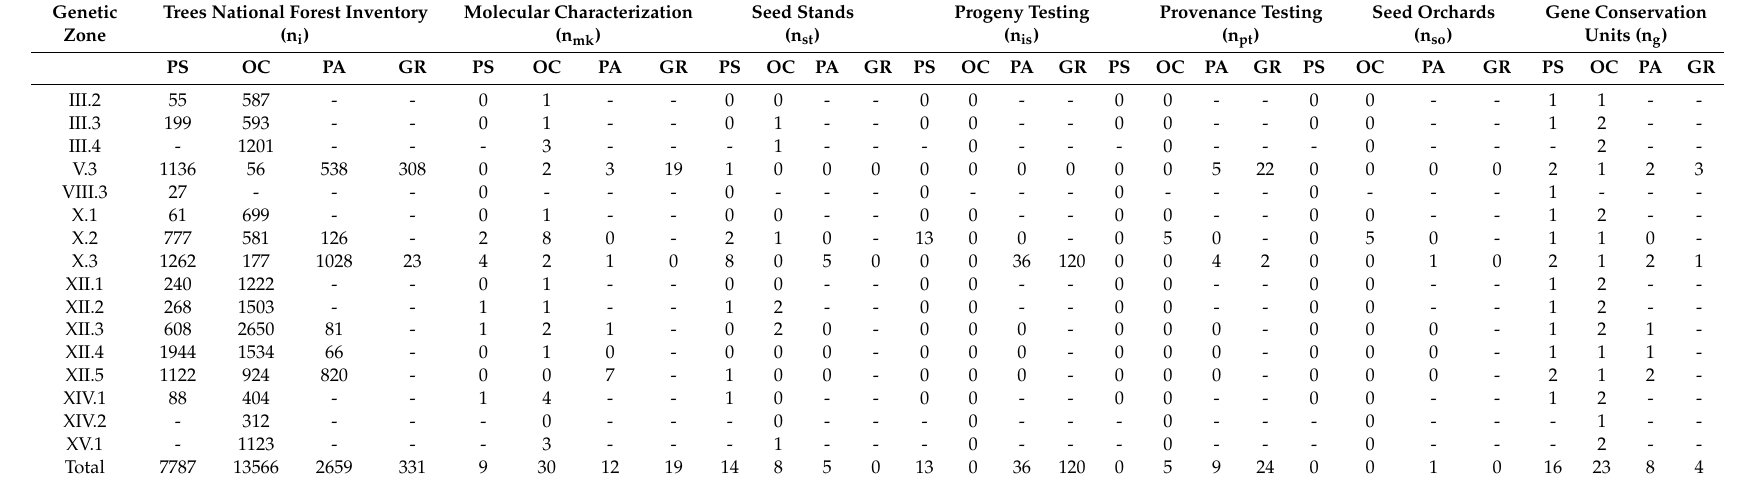
Table 2. Conservation e ff orts and use of genetic resources by genetic zone and species (PS: P. pseudsotrobus Lindl., OC: P. oocarpa Schiede ex Schltdl., PA: P. patula Schiede ex Schltdl. & Cham., GR: P. greggii Engelm. ex Parl.). Genetic Trees National Forest Inventory Zone (n i